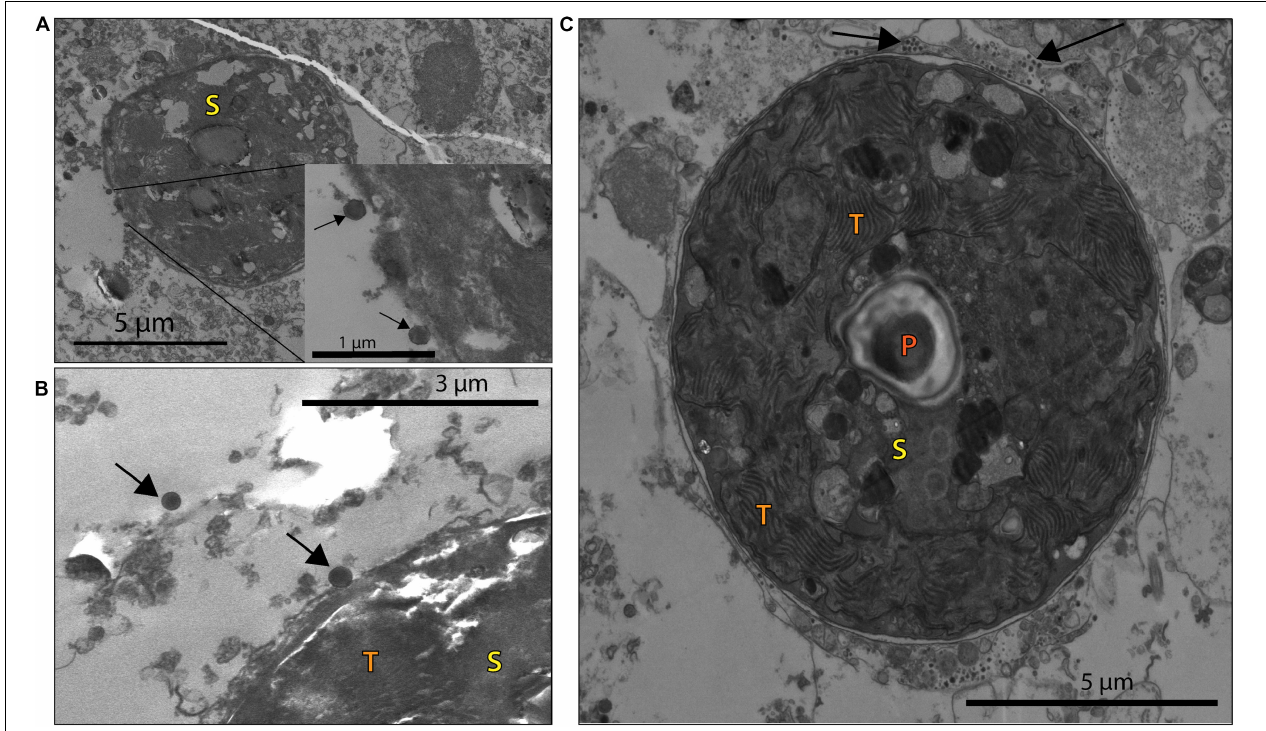
FIGURE 4 | VLP associated with coral B and NB Symbiodiniaceae cells (S), with visible pyrenoid (P) and thylakoid membrane (T) structures. (A) VLPs ∼ 170 nm in diameter (black arrows) closely associated with a Symbiodiniaceae cell in a NB sample. (B) Larger VLPs ( ∼ 200 nm in diameter, arrows) close to a B sample Symbiodiniaceae cell. (C) Whole Symbiodiniaceae cell, from NB sample, with VLPs ( ∼ 40 nm in diameter, arrows) around and within the